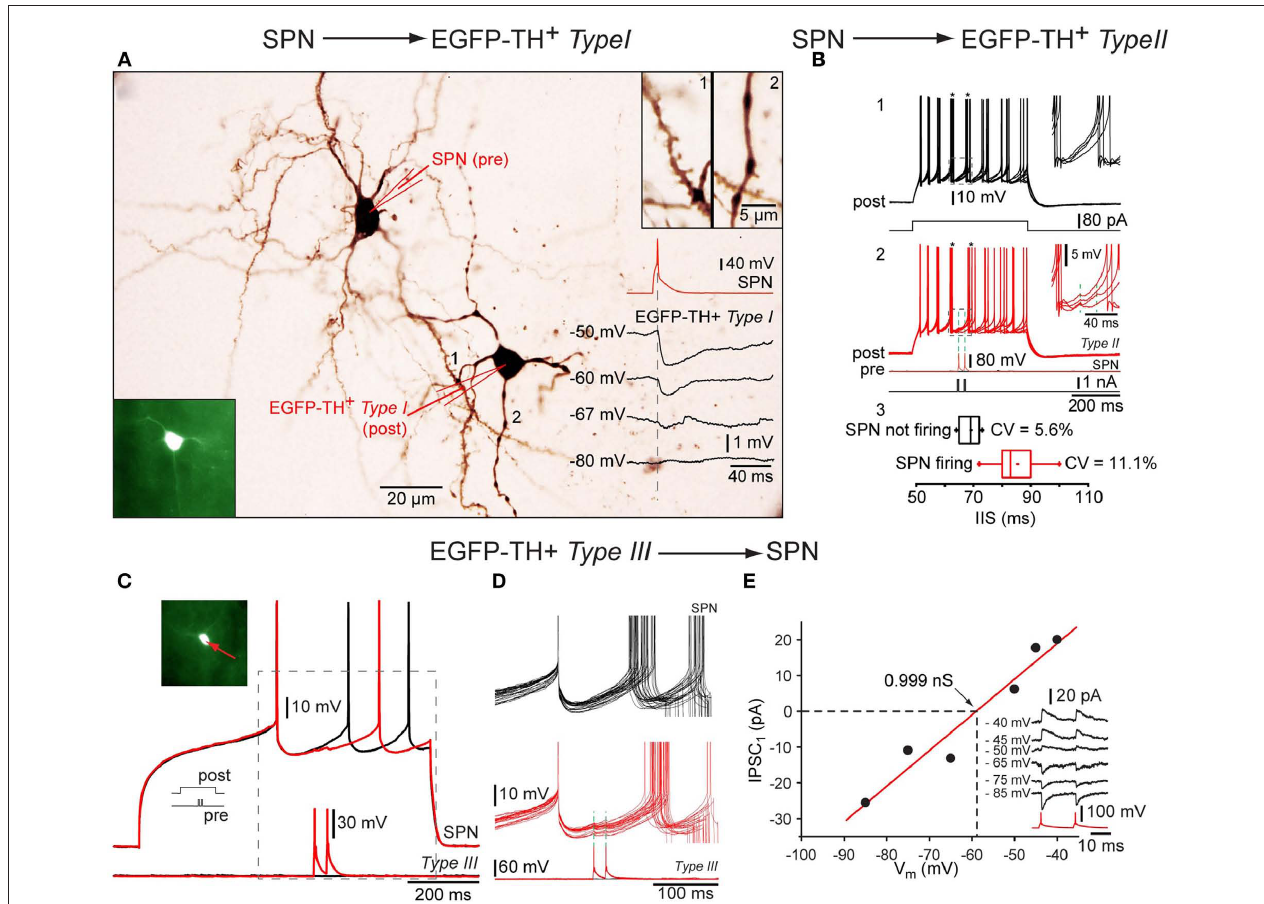
reversal near − 67 mV. (B) Depolarization evoked repetitive firing of a Type II neuron (1, black traces) is interrupted at the time indicated by the asterisks by single spikes of evoked in the presynaptic SPN (2, red traces) Inset shows the IPSP enlarged. Panel 3 shows the cumulative data for the inter-spike intervals with (black) and with presynaptic activity (red). (C) An analogous experiment shows delay in the depolarization induced spiking in an SPN (top red and black traces) by two spikes in the presynaptic Type III interneuron. (D) Higher magnification of the IPSP. Note the reliability of transmission. (E ) I – V plot for the synaptic response in (C) and (D) showing a reversal potential as expected for Cl − and providing an estimate of the synaptic conductance ( ∼ 1